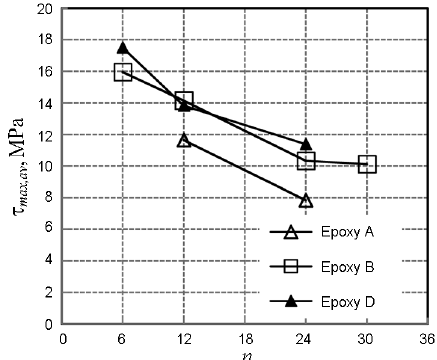
Fig. 13. Effect of epoxy type and bond length for specimens with GFRP bars on τ max,av ( n = L b / d b